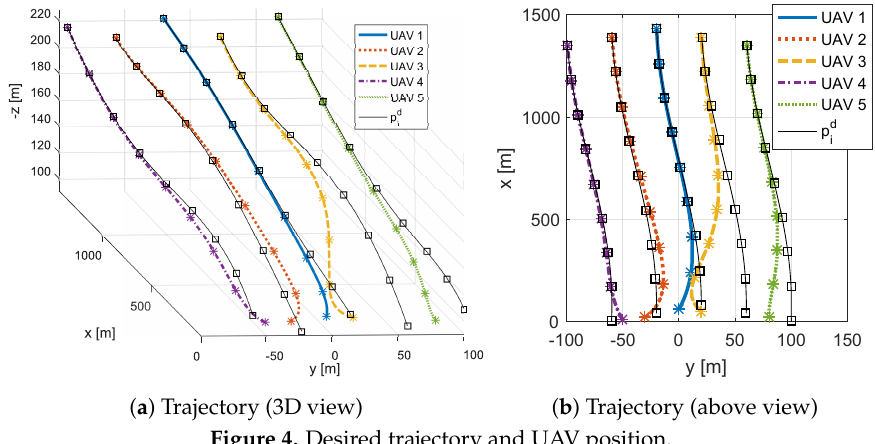
Figure 4. Desired trajectory and UAV